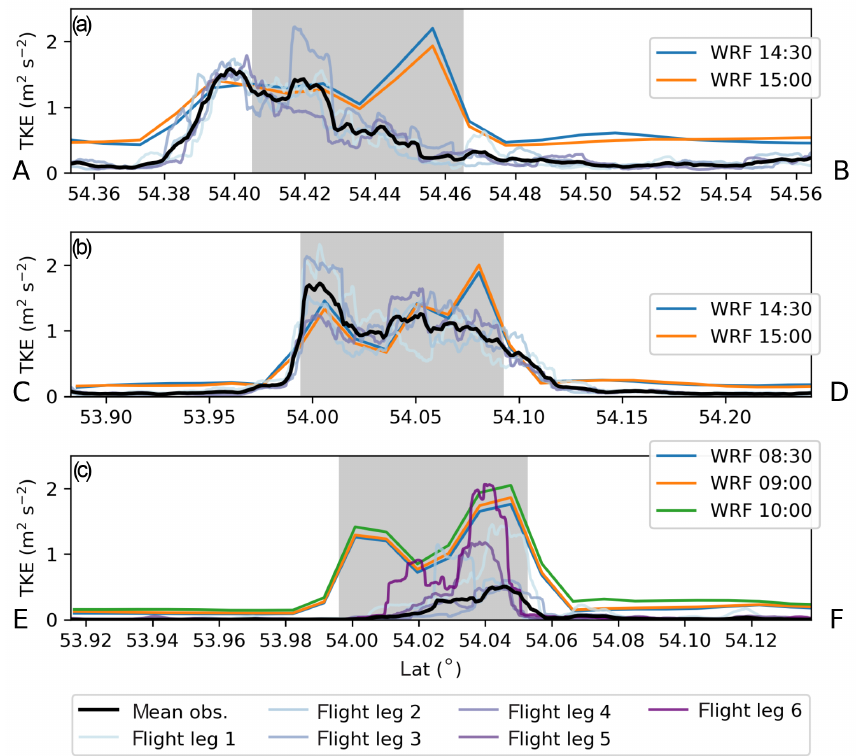
Figure 10. As in Fig. 8 but for the